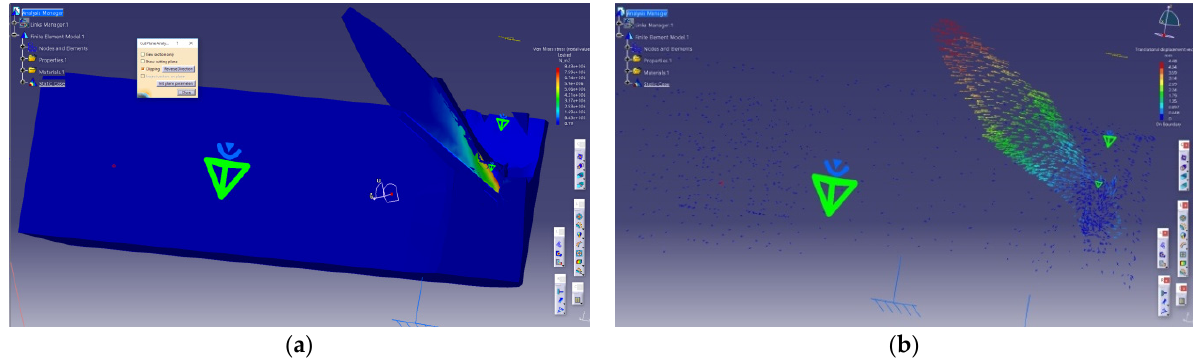
Figure 3. Lingualization of the LCI using a 1 N force: ( a ) von Mises tensions, 33% HBL; ( b ) tooth movement, 33% HBL.